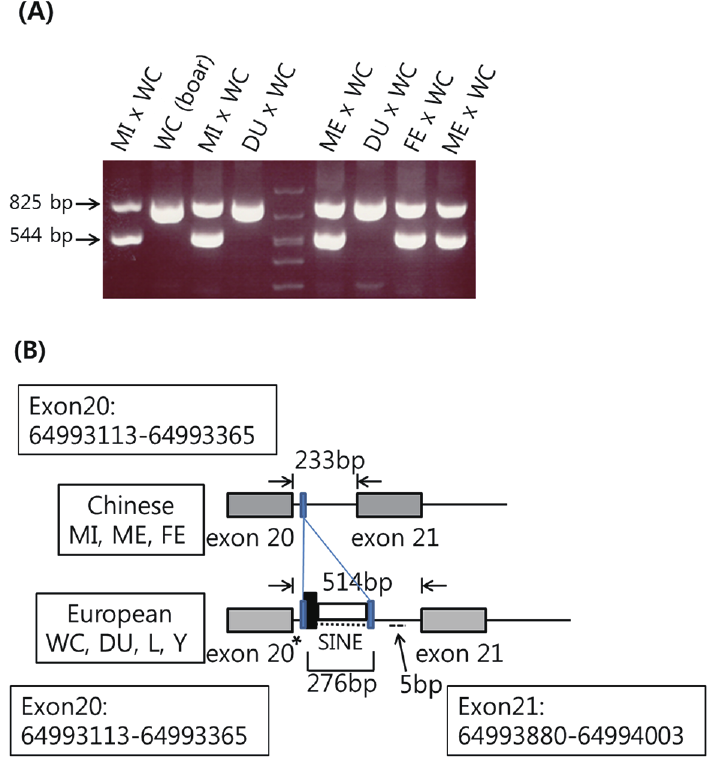
Figure 1. (A) Intron 20 of O-linked N-acetylglucosamine transferase (OGT) from European and Chinese pig breeds. Fragments containing intron 20 of OGT were compared by amplifying the region containing a part of exon 20, intron 20, and a part of exon 21 of OGT. All of polymerase chain reaction amplicons from Minzu (MI)×White composite (WC), Meishan (ME) ×WC, and Fengzing (FE)×WC sows had both 825-bp and 544-bp bands, while those from Duroc (DU)×WC sows and a WC boar had only the 825-bp band. (B) Schematic diagram of intron 20 of OGT in Chinese and European pigs. The intron 20 of Chinese pigs including MI, ME, and FE was 233 bp, while that of European pigs including WC, DU, Landrace (L), and Yorkshire (Y) was 514 bp, resulting in the 281-bp difference. The longer 514-bp intron 20 of OGT from European pigs contained an inserted 276-bp element (·····) near the beginning of the intron and GACTT (--) insertion at nucleotides 401-405 of the 514 bp intron 20. The 276-bp element (chrX:64993408-64993683) of the European pigs is located after the first 14-bp TGCTTGTTCTTTTT (chrX:64993394-64993407) sequence and the 3’-end of the element ends with the second 14-bp TGCTTGTTCTTTTT (chrX:64993670-64993683) sequence, shown as blue narrow rectangles and the Chinese pigs have only one such sequence. Black rectangle indicates the 33-bp (TTG) simple repeat 7 (chrX:64993397-64993429) and it included the 4 to 14 bp of the 14-bp TGCTTGTTCTTTTT sequence and the (TTG) repeat sequence. The 240-bp SINE element (chrX:64993430- 7 64993669), following the 33-bp (TTG)